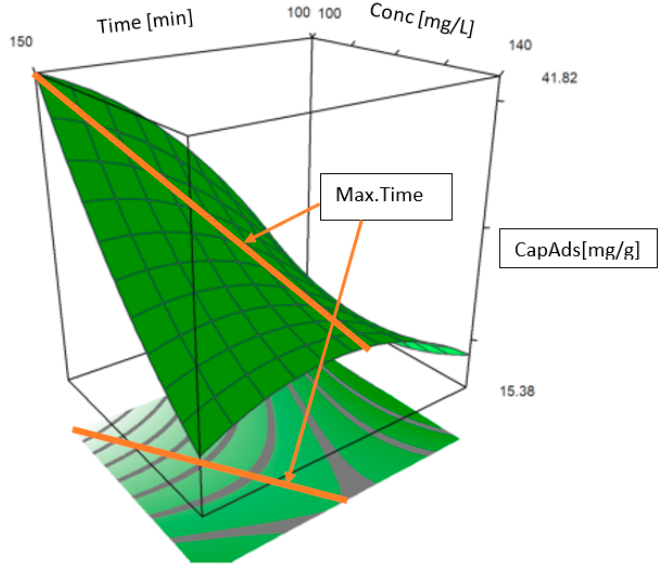
Figure 15. Dependence of the contact time upon the initial Au (III) concentration during the ad- sorption process using